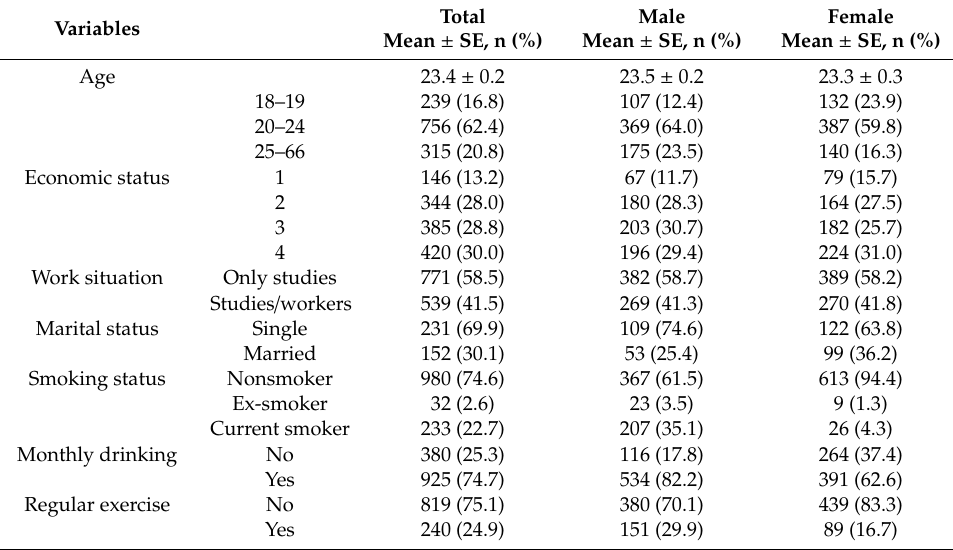
Table 1. Demographic characteristics (n = 1310).